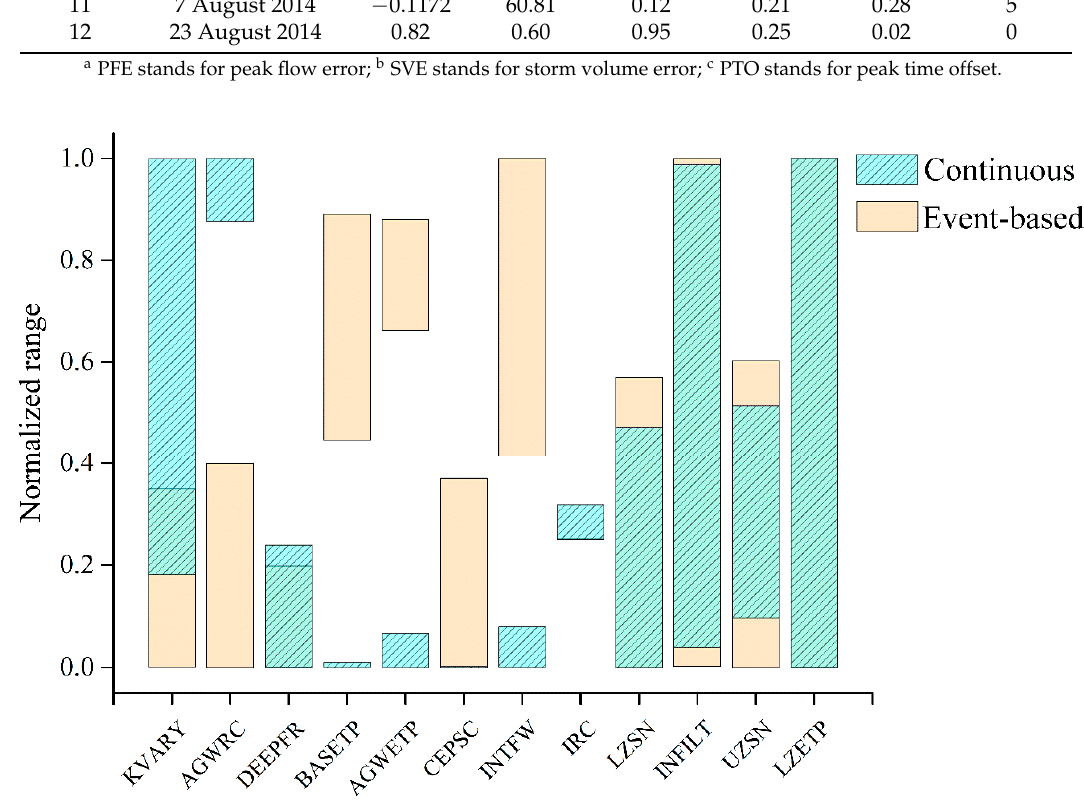
Figure 8. Comparison of the optimized parameter ranges between the continuous and event-based modeling. Table 6. Water balance comparison between the continuous and event scenarios in pervious lands.